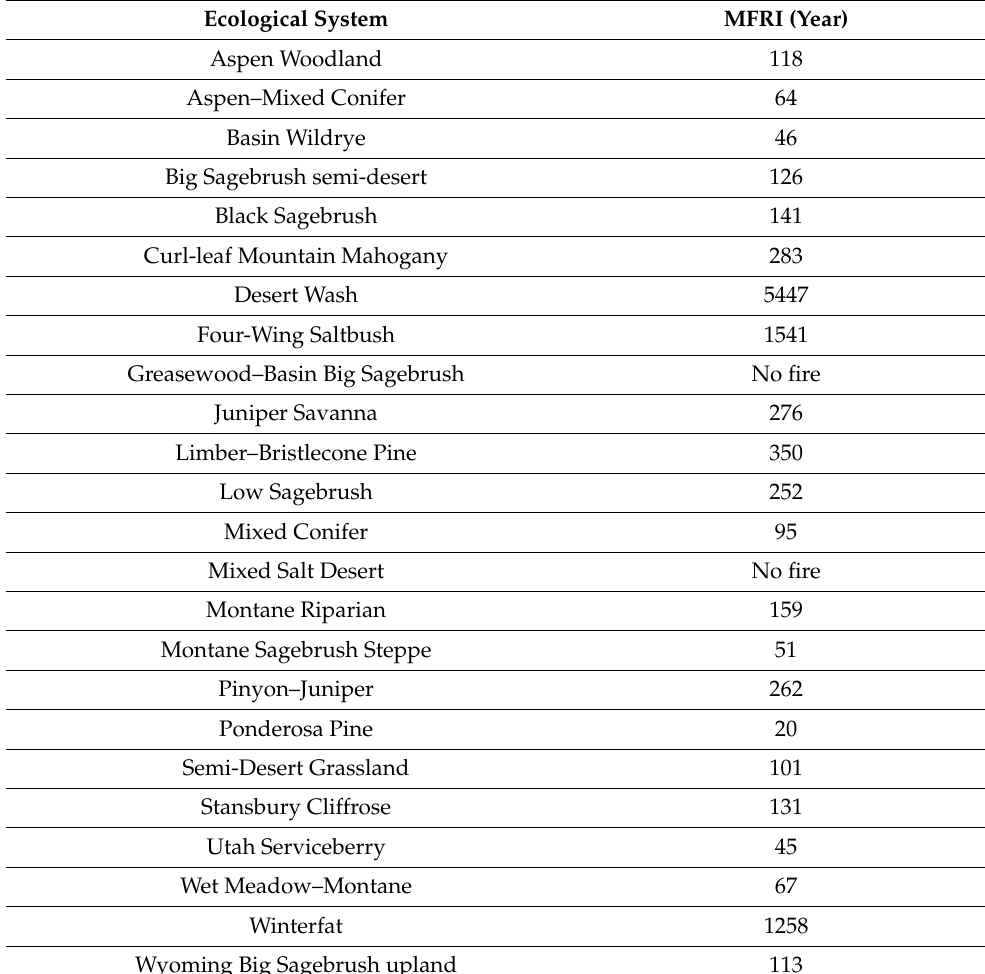
Table 1. Reference mean fire return interval (MFRI) of ecological systems assuming presettlement vegetation and dynamics. The MFRI is the mean weighted by the area of each class in the ecologi- cal